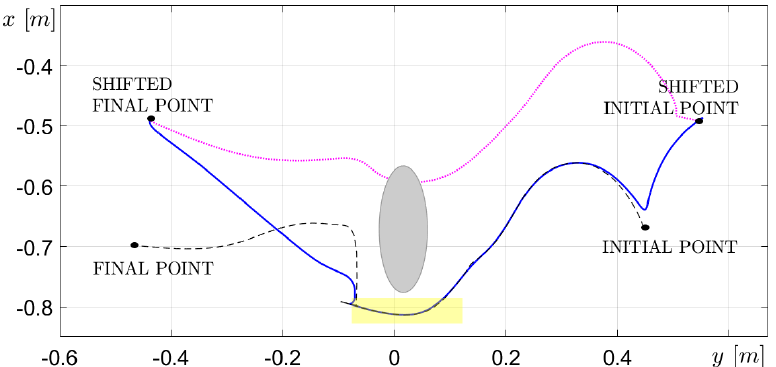
Figure 4. Comparison between the trajectory generated with the proposed algorithm (solid blue line) and without (dotted purple line), when changing the initial and final points. The trajectory with the manual correction is represented by a dashed black line and the obstacle with a gray circle. The manual correction that has to be constant is highlighted.